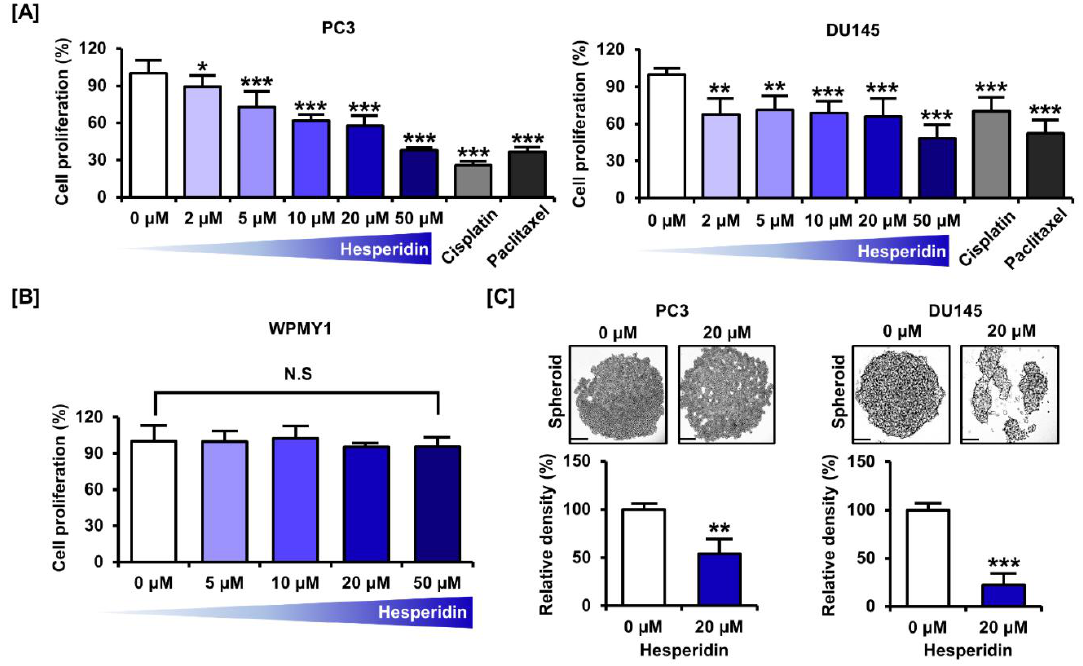
Figure 1. Effect of hesperidin on the proliferation of prostate cancer cells. ( A ) Relative proliferation of PC3 and DU145 cells was verified after dose-dependent treatment with hesperidin (0, 2, 5, 10, 20, and 50 μM), cisplatin (5 μM), and paclitaxel (5 μM) for 48 h. ( B ) Relative proliferation of WPMY1 cells was verified after dose-dep endent treatment with hesperidin (0, 5, 10, 20, and 50 μM) for 48 h. ( C ) Effects of hesperidin on spheroid formation in PC3 and DU145 cells. Scale bar represents 300 μm. All results of the arithmetic mean ( n = 3) denote statistical significance with asterisks (* p < 0.05, ** p < 0.01 and *** p < 0.001).